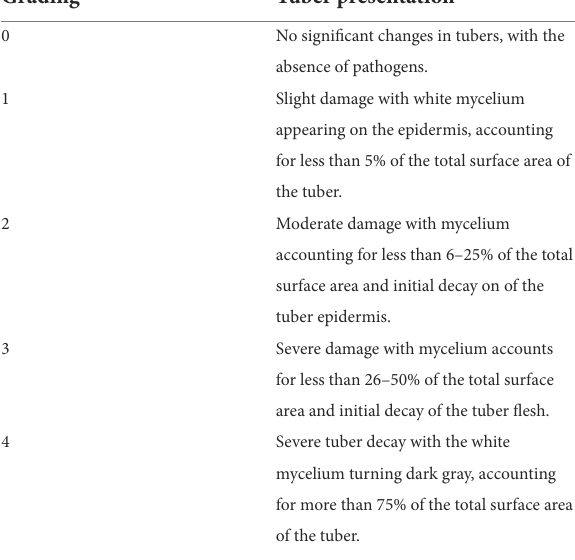
TABLE 1 Grading criteria for rotting disease in stored Jerusalem artichoke